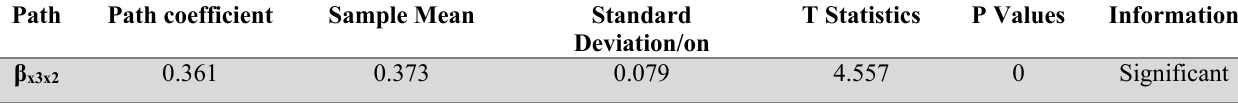
Calculation Results and Testing of the Path Coefficient Model 2 Sub-Structure-1